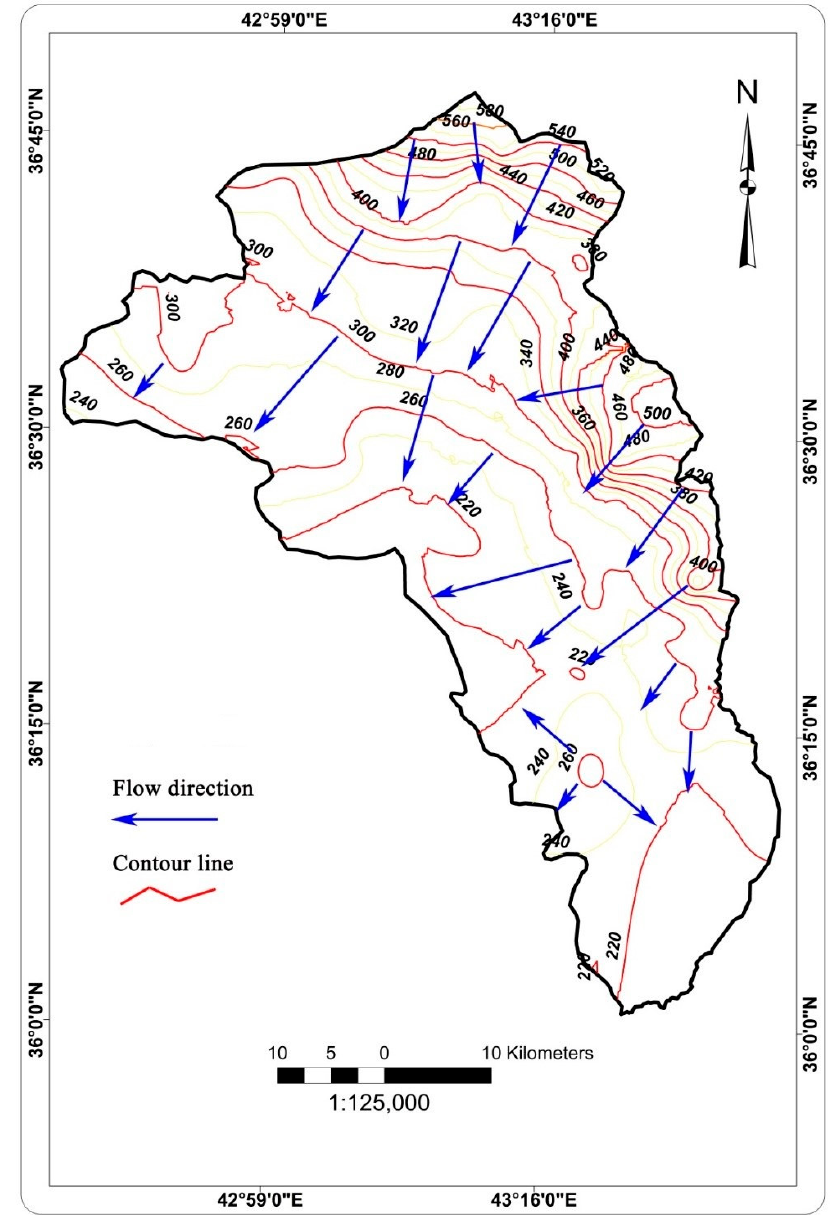
Figure 7. Groundwater levels (m) and the flow direction in the study area.